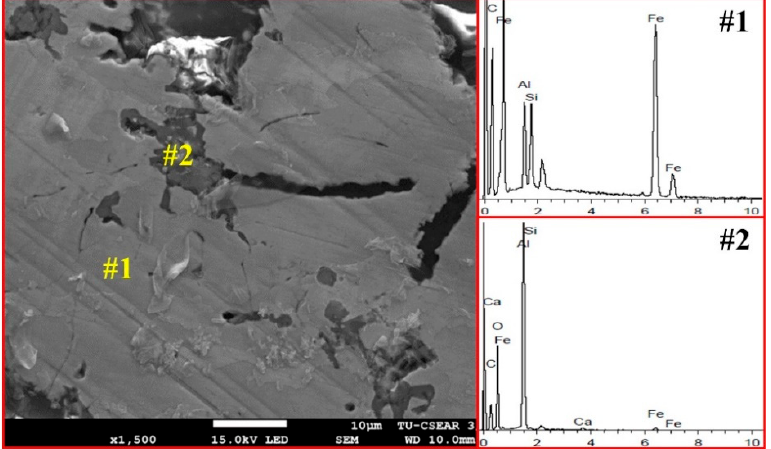
Figure 8. SEM micrograph and EDS spectra of the cross-sectioned pellet (C/O = 1.5) after heating at 1550 °C for 3 h.